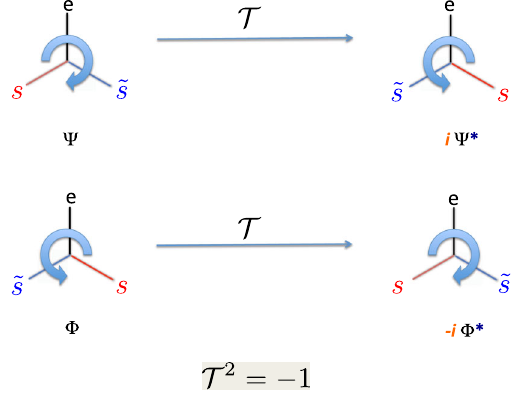
FIG. 3. Origin of T 2 ¼ (cid:1) 1 in Walker-Wang models of SO ð 3 Þ surface topological order. The additional phase factor shown in red depends on the orientation of the vertices and is required to ensure time-reversal symmetry. This leads to T 2 ¼ (cid:1) 1 for fermions in this